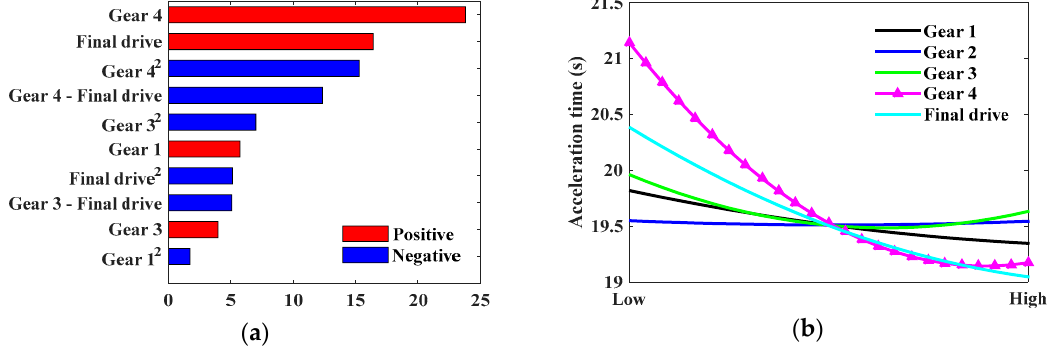
Figure 11. Response (acceleration time). ( a ) Effect on acceleration time (%); ( b ) Main effect.